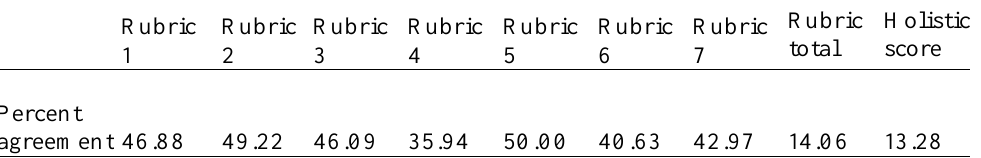
Percent Agreement between Instructor and AES-Scores – Philosophy